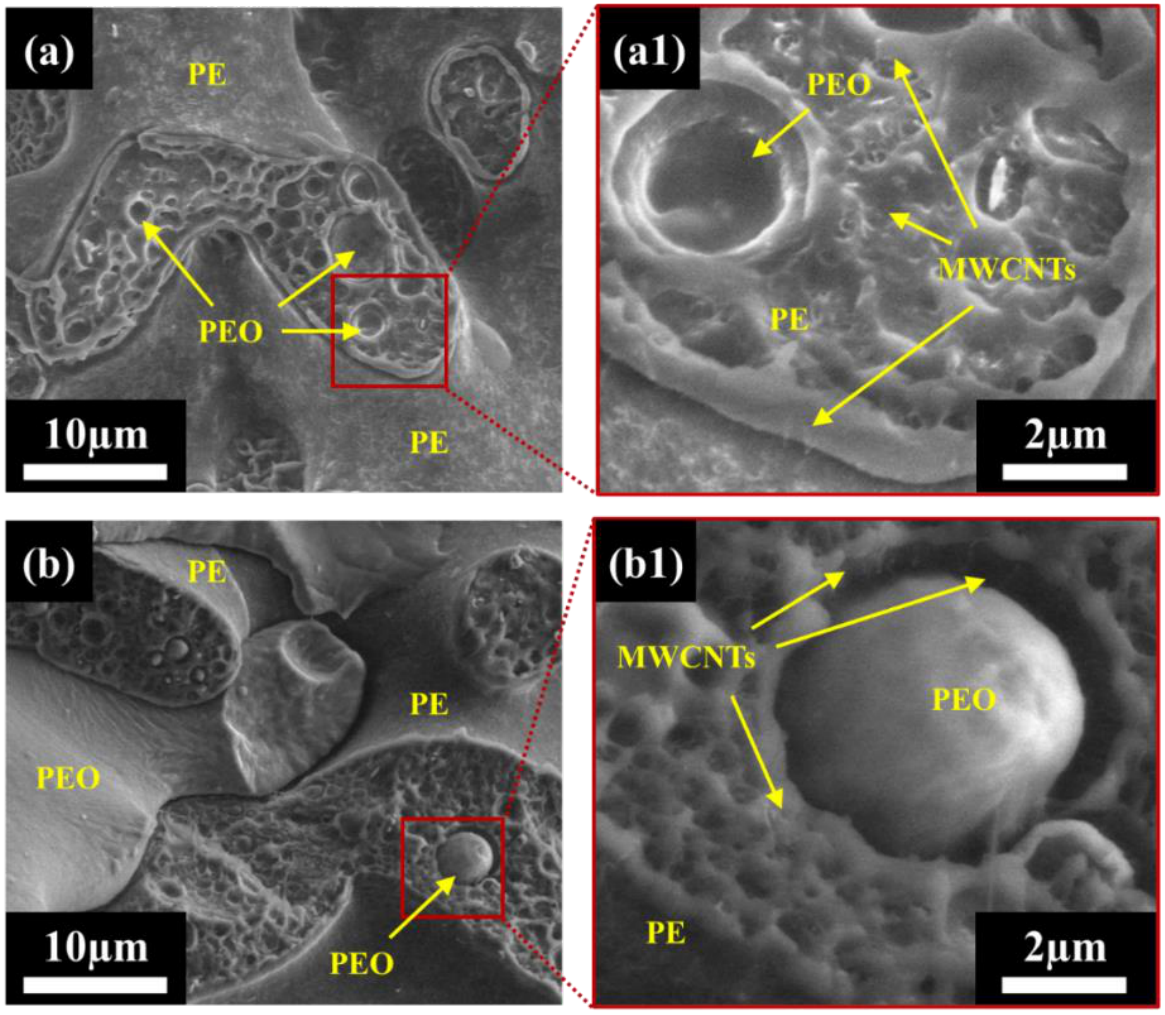
Figure 2. Low field detector (LFD) SEM images of PEO/PE 40:60 with 0.5 vol% MWCNTs mixed for ( a ) 1 min and ( b ) 10 min. Images ( a1 ) and ( b1 ) show PEO droplets at higher magnification.